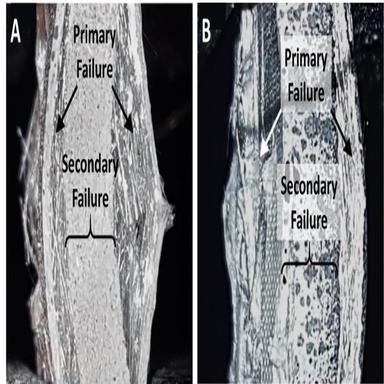
Typical photographs of compression failure mechanisms. (A) Type A configuration, (B) Type B configuration.